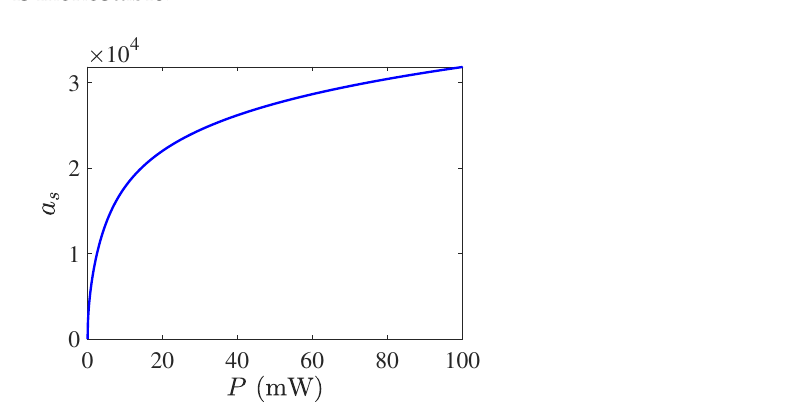
Figure A1. The steady-state mean value of the cavity mode a s is plotted with the power of the driving field P . The other parameters are the same as given in Figure